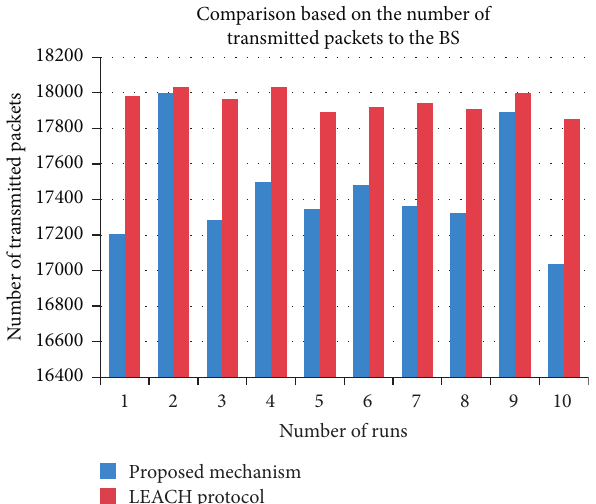
Figure 9: Comparison between the two mechanisms based on number of transmitted packets to the